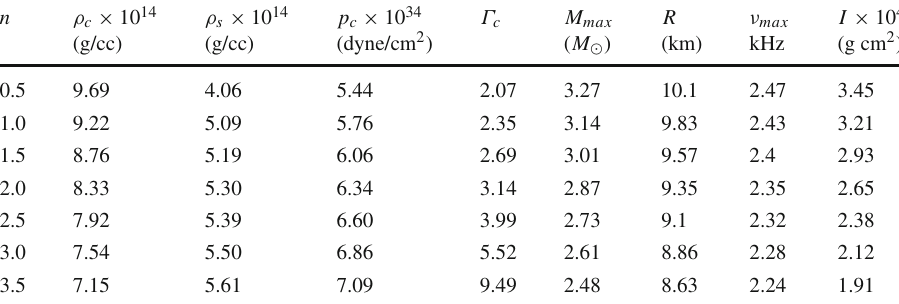
parameters for 4U 1608-52 ( M = 1 . 74 M (cid:9) , R = 9 . 528 km) by taking a = 0 . 001 km − 2 and β = 0 .